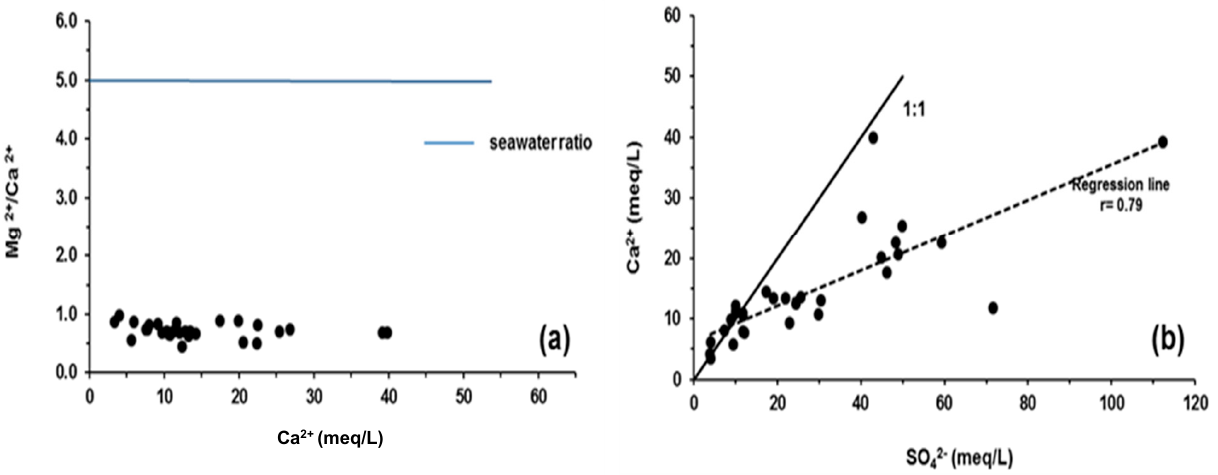
Figure 8. Mg/Ca vs. Ca ( a ) and Ca vs. SO 42 − ( b ) diagrams for groundwater (Mio–Pliocene aquifer) of the study region.